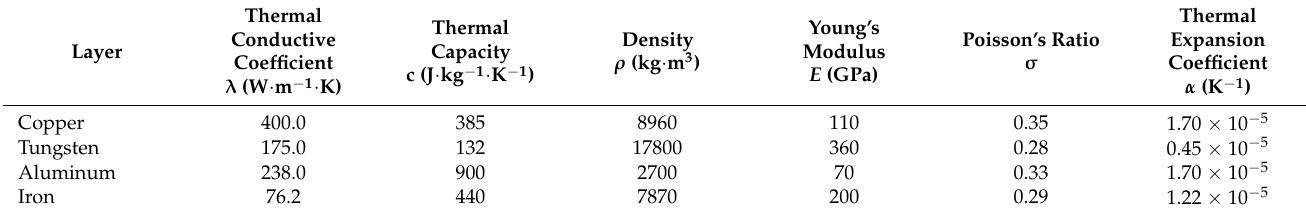
Table 1. Material parameters used in simulation cases.